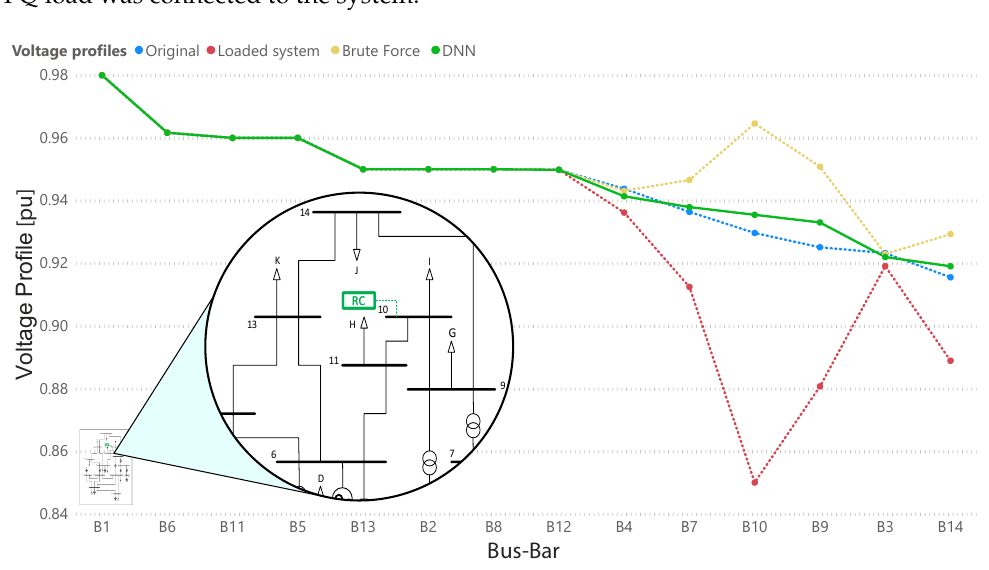
Figure 5. Voltage profiles for 14 bus-bar system: original system, loaded system, BFA and DNN compensation—BFA and DNN present similar